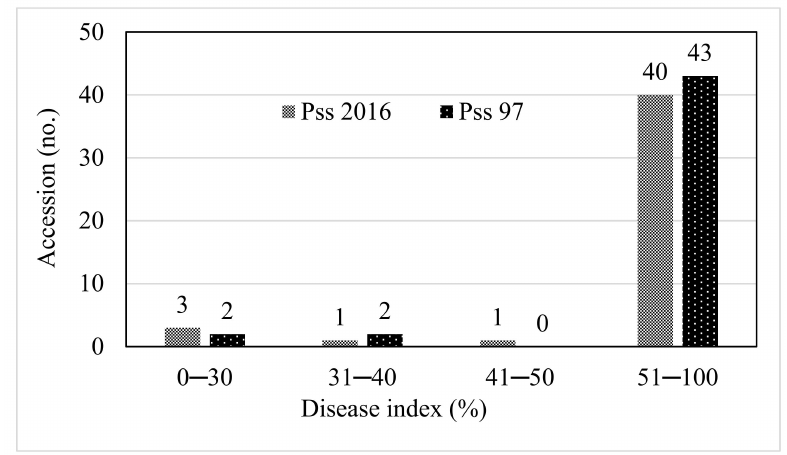
Figure 2. Frequency distribution of bacterial wilt resistance based on disease index (DI) for cultivated and wild relative eggplant accessions evaluated resistance to Ralstonia solanacearum strains Pss97 and Pss2016 at four weeks after